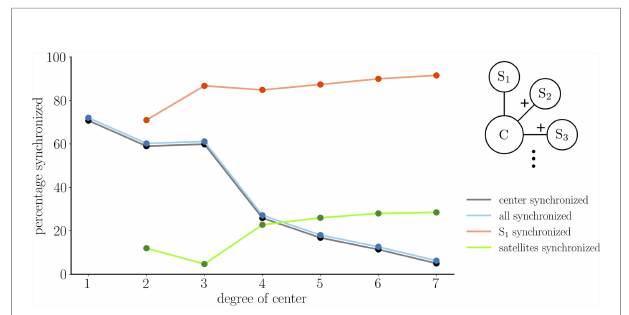
FIGURE 5 | Results from center/satellite networks as the number of satellites, or the degree of the center node, is increased. The percentages of synchronized cells was based on 1000 trials in which initial conditions were chosen randomly. The cyan curve represents asymptotic states in which the center cell is synchronized with all satellites, which is identical to the number of trials in which the center is synchronized with at least one satellite (gray curve, shifted down for visibility). The green curve represents asymptotic states in which the satellites are all synchronized, but not with the center cell. The red curve represents cases in which satellite cell S 1 is synchronized with other cells. The latter two curves begin at degree=2 since this is when the structural distinction between “ satellite ” and “ center ” cells fi rst